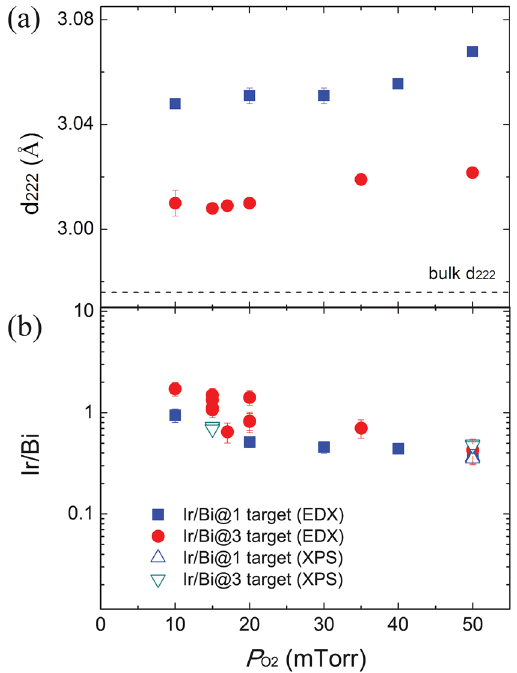
Figure 2. ( a ) lattice spacing d 222 versus oxygen pressure P O2 . The error bars were estimated according to the diffraction peaks. ( b ) Ir/Bi ratio versus P O2 (multiple data points at the same pressure were taken at different spots/areas of the sample). The error bars were determined based on the EDX analysis in the AZtech